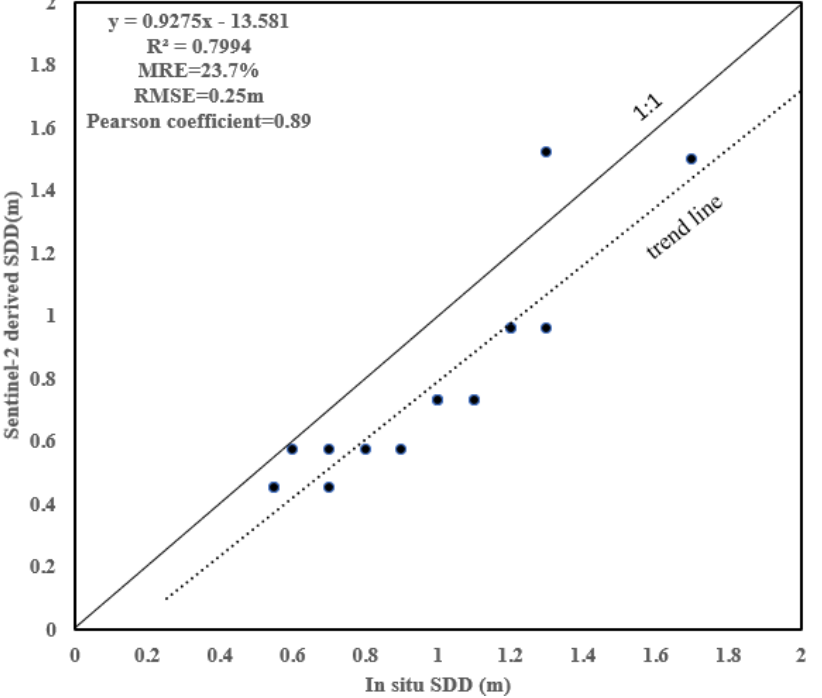
Figure 3. Scatterplots showing the derivation of the accuracies of Sentinel-2 derived SDD in comparison with in situ SDD.